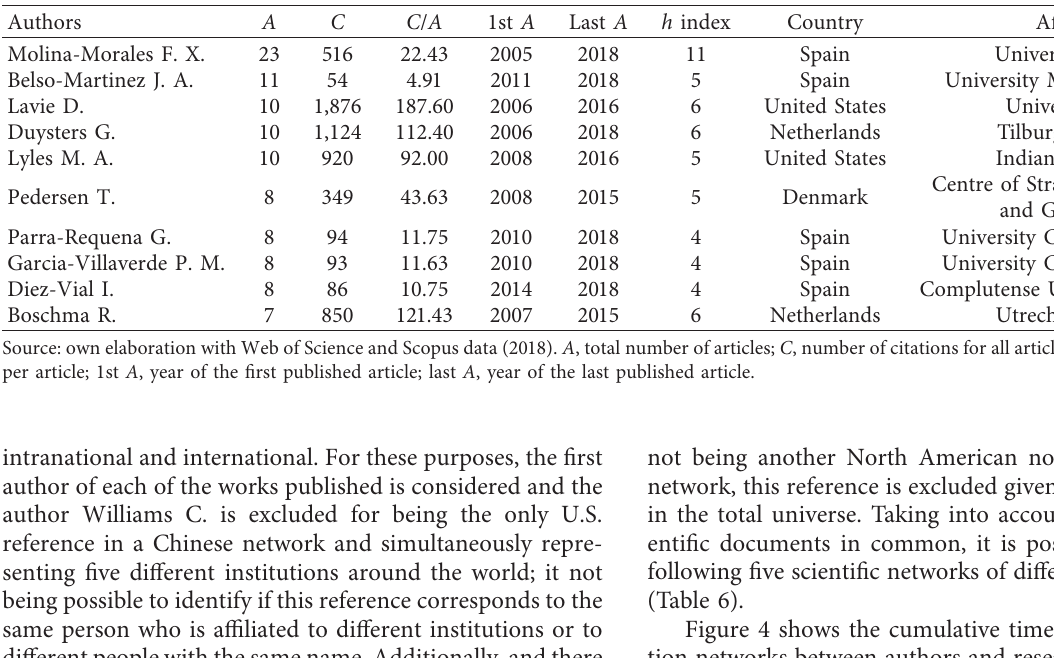
Table 5: Ten most productive